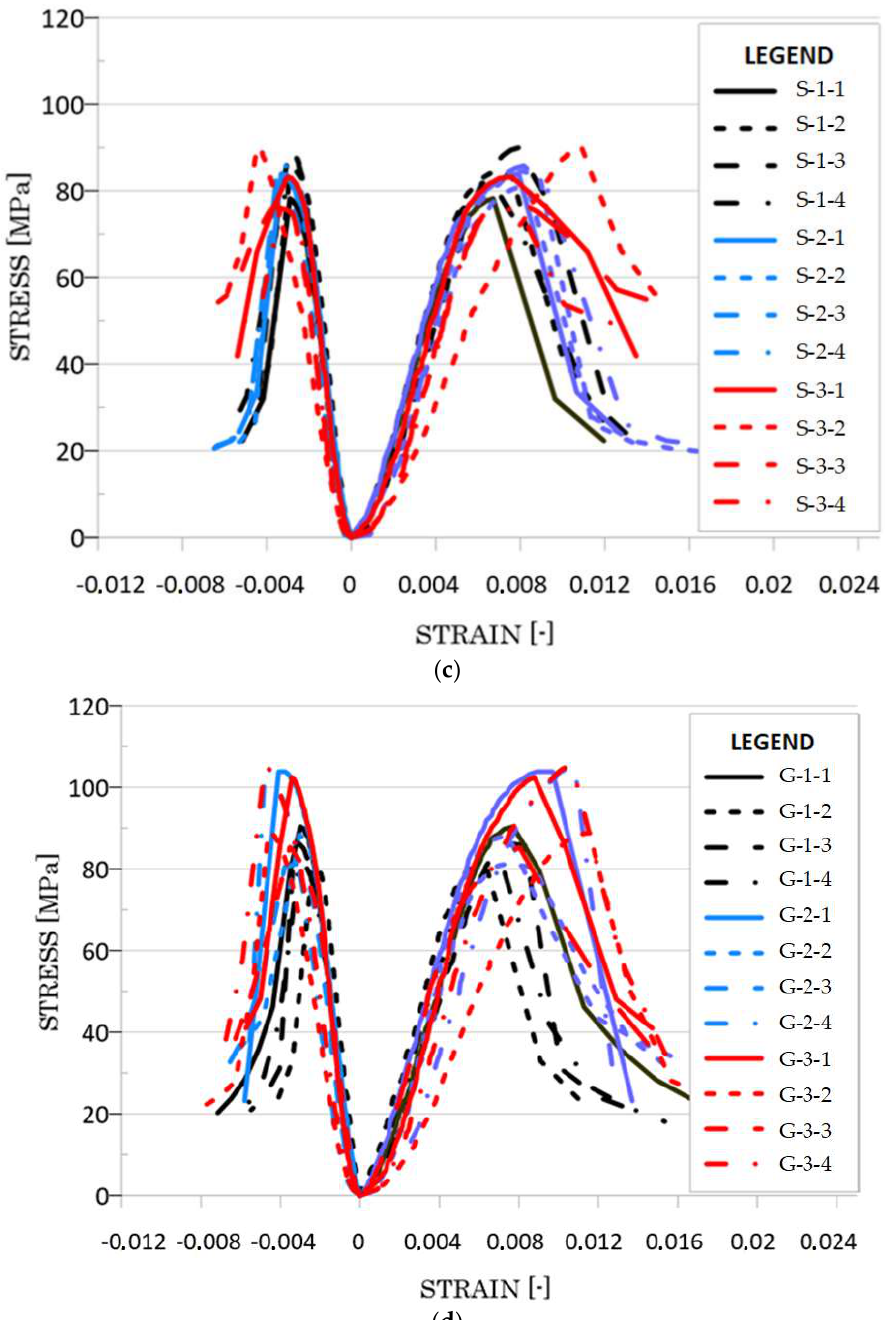
Figure 8. Stress-strain characteristics for: HPSCFRC ( a ); HPSCFRC reinforced carbon fibre reinforced polymer (CFRP) with an unprepared concrete surface ( b ); HPSCFRC reinforced CFRP with a sanded concrete surface ( c ); HPSCFRC reinforced CFRP with grinded concrete surface ( d ).